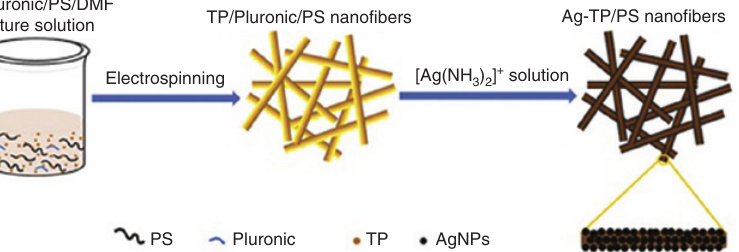
Figure 11: Schematic illustration of the preparation of Ag-TP/PS nanofiber membrane. For details, see Ref. [49]; reprinted with permission from Elsevier.